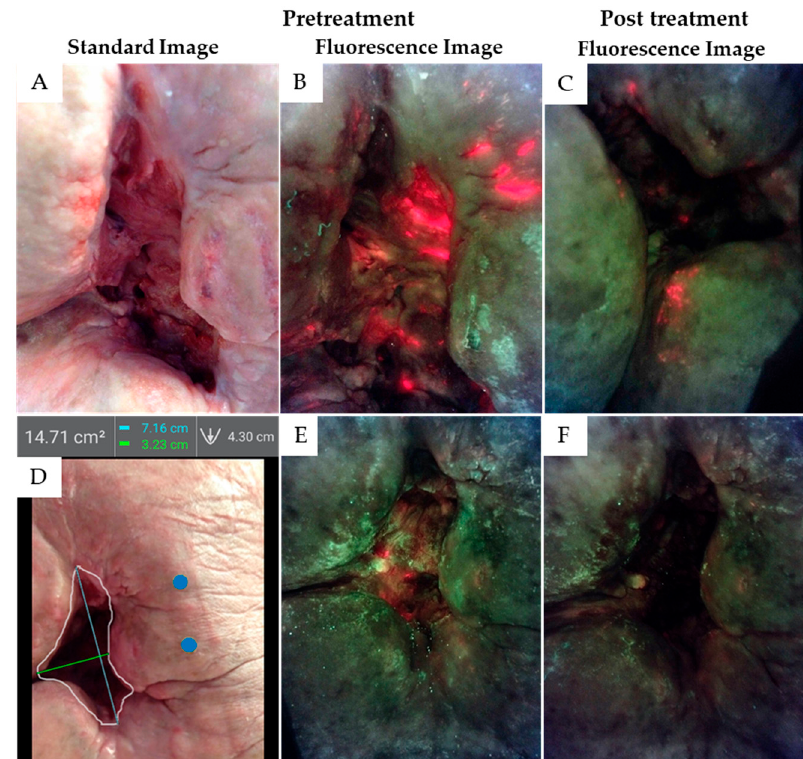
Figure 2. Case 1 . ( A ) This stage 4 pelvic pressure injury (35 cm 2 ) over the sacrum had been treated with jet lavage irrigation for approximately 5 months. This patient developed signs of septicemia, though this wound has modest slough and does not appear grossly infected. ( B ) Autofluorescence bacterial imaging with a DarkDrape revealed extensive bacterial infestation demonstrated by red fluorescence observed in the wound bed and peri-wound area. After treatment, red bacterial autofluorescence was reduced but still present ( C ). Eight months later, a 25% reduction in wound size ( D ) was observed (blue dots calibrate planimetry measurements), but some red bacterial fluorescence persisted ( E ), prompting additional treatment. After treatment using pulsatile irrigation and antiseptic under pressure, the wound was re-imaged and bacterial autofluorescence was no longer detected ( F ).